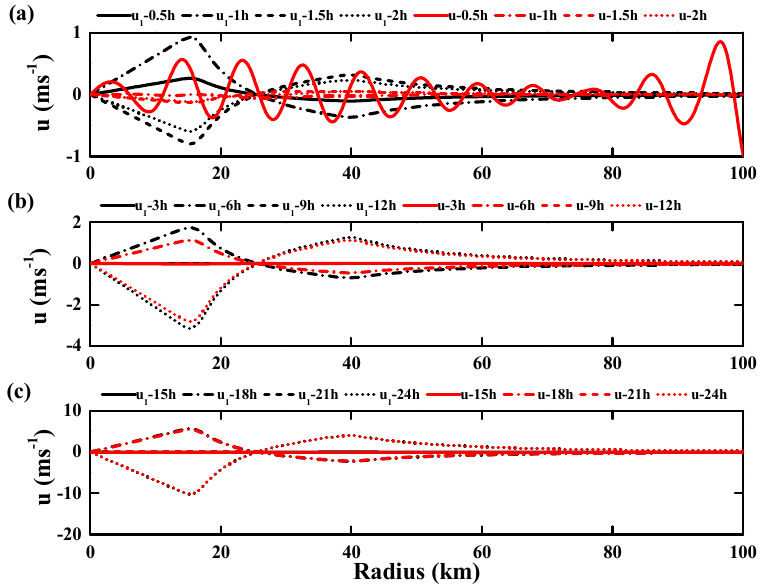
Figure 5. The evolution of the radial perturbation wind obtained from the most unstable mode (black lines) and the linear-superimposed all eigenmodes (red lines). ( a ) the integration time from 0.5–2 h; ( b ) the integration time from 3–12 h; ( c ) the integration time from 15–24 h.